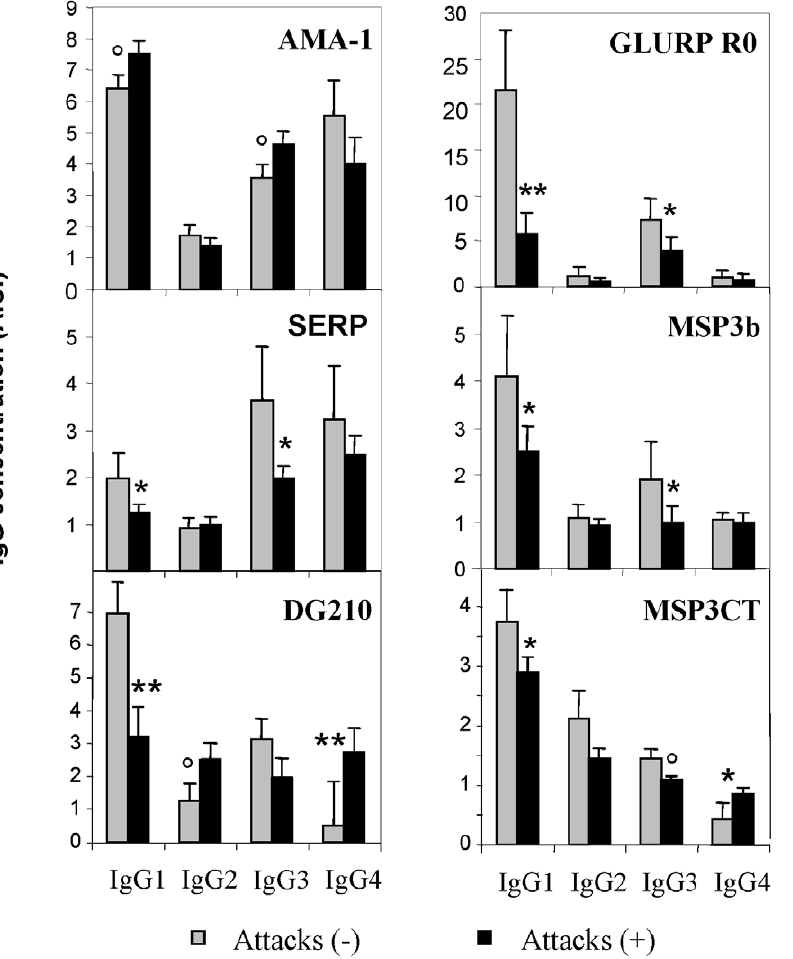
Figure 1. Antigen-specific antibody responses and occurence of malaria attacks. Mean reactivity in ELISA assays determined in sera from children presenting with (malaria attacks + ), or without (malaria attacks 2 ) clinical malaria during the follow-up. Sera samples were tested using different antigens and mean results for AMA-1, SERP-SERA, GLURP-R0, MSP3b, DG210 and MSP3CT are shown with standard errors of the mean IgG A.U. Labels indicate when differences were found significant in univariate analysis: u when 0.06 . p $ 0.05, * when 0.05 , p $ 0.0021 and ** when p , 0.0021 (a p value of 0.0021 accounts for the multiplicity of tests carried out).